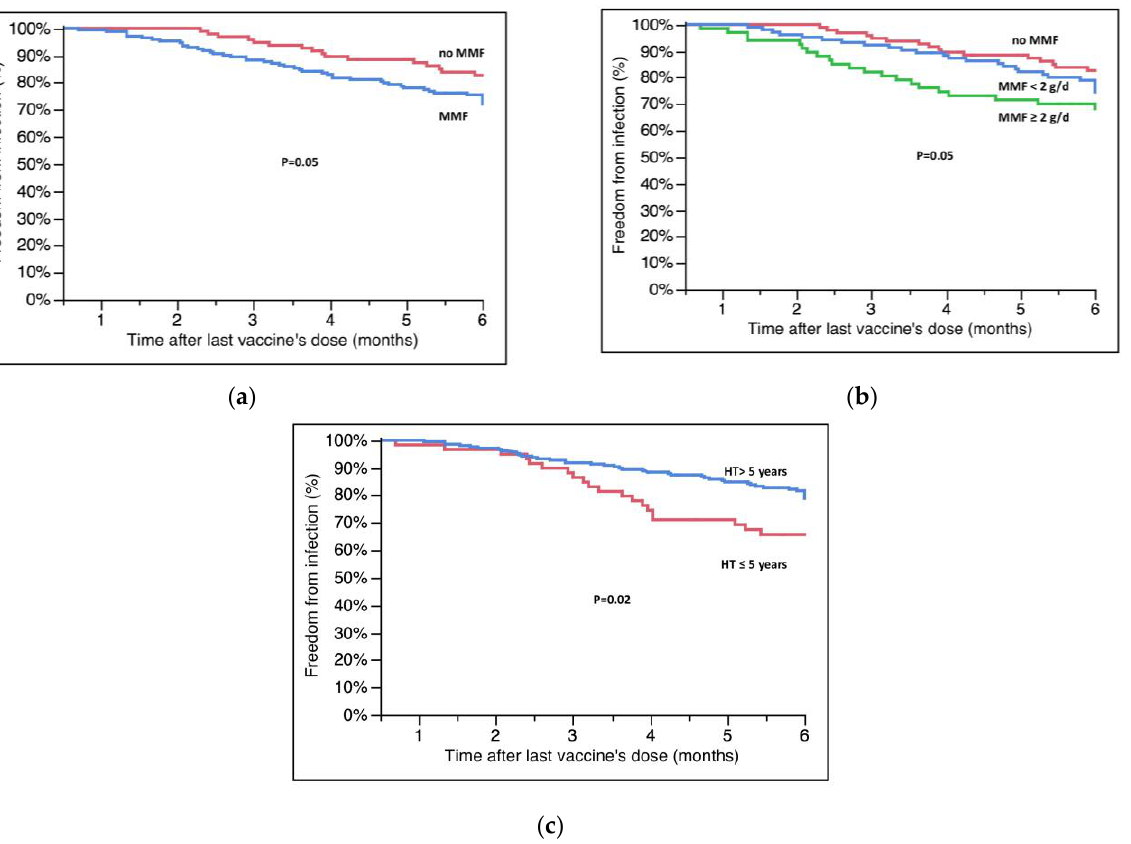
Figure 2. ( a ) Survival free from infection according to MMF therapy. ( b ) Survival free from infection according to dose of MMF at the moment of last vaccination. ( c ) Effect of time from HT on infections. Survival rates are reported in the text; g/d = grams/day. Table 4. ( A ) Multivariate analysis for the endpoint of SARS-CoV-2 infection 6 months after the last dose of vaccine (model including MMF but not its dose). ( B ) Multivariate analysis for the endpoint of SARS-CoV-2 infection 6 months after the last dose of vaccine (model including MMF dose). A Variable HR (95% CI) p Vaccine doses (four vs. three)